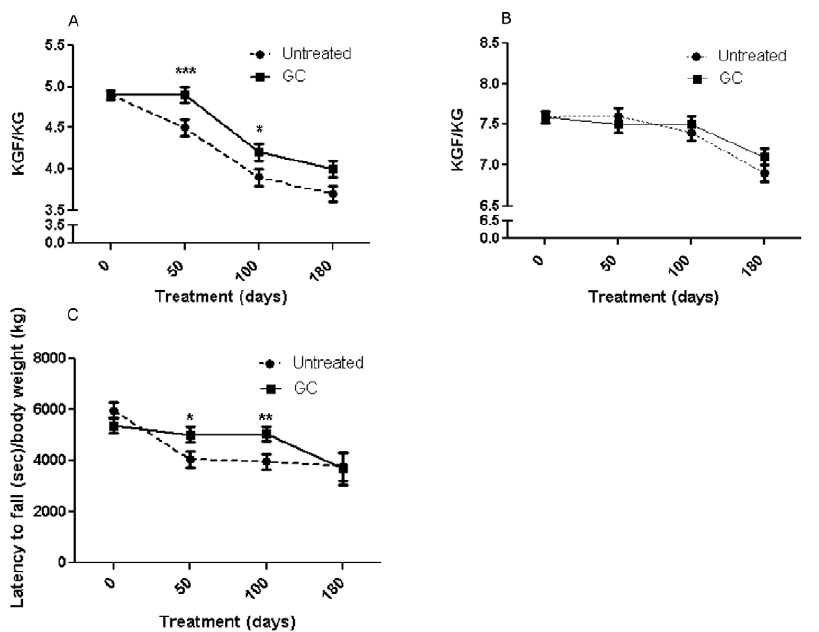
Figure 2. Effect of treatments on normalized grip strength. ( A ) Forelimb grip strength and ( B ) Hindlimb grip strength were measured using a grid at 50, 100, and 180 days of age. ( C ) Latency to fall normalized to body weight was measured using a rotating rod. mdx mice received no treatment (N=84, 82, and 44) or GC treatment (N=92, 87, and 38) for 50, 100, or 180 days, respectively. Error bars indicate mean + /- SEM. ** p = , 0.01 and * p = ,